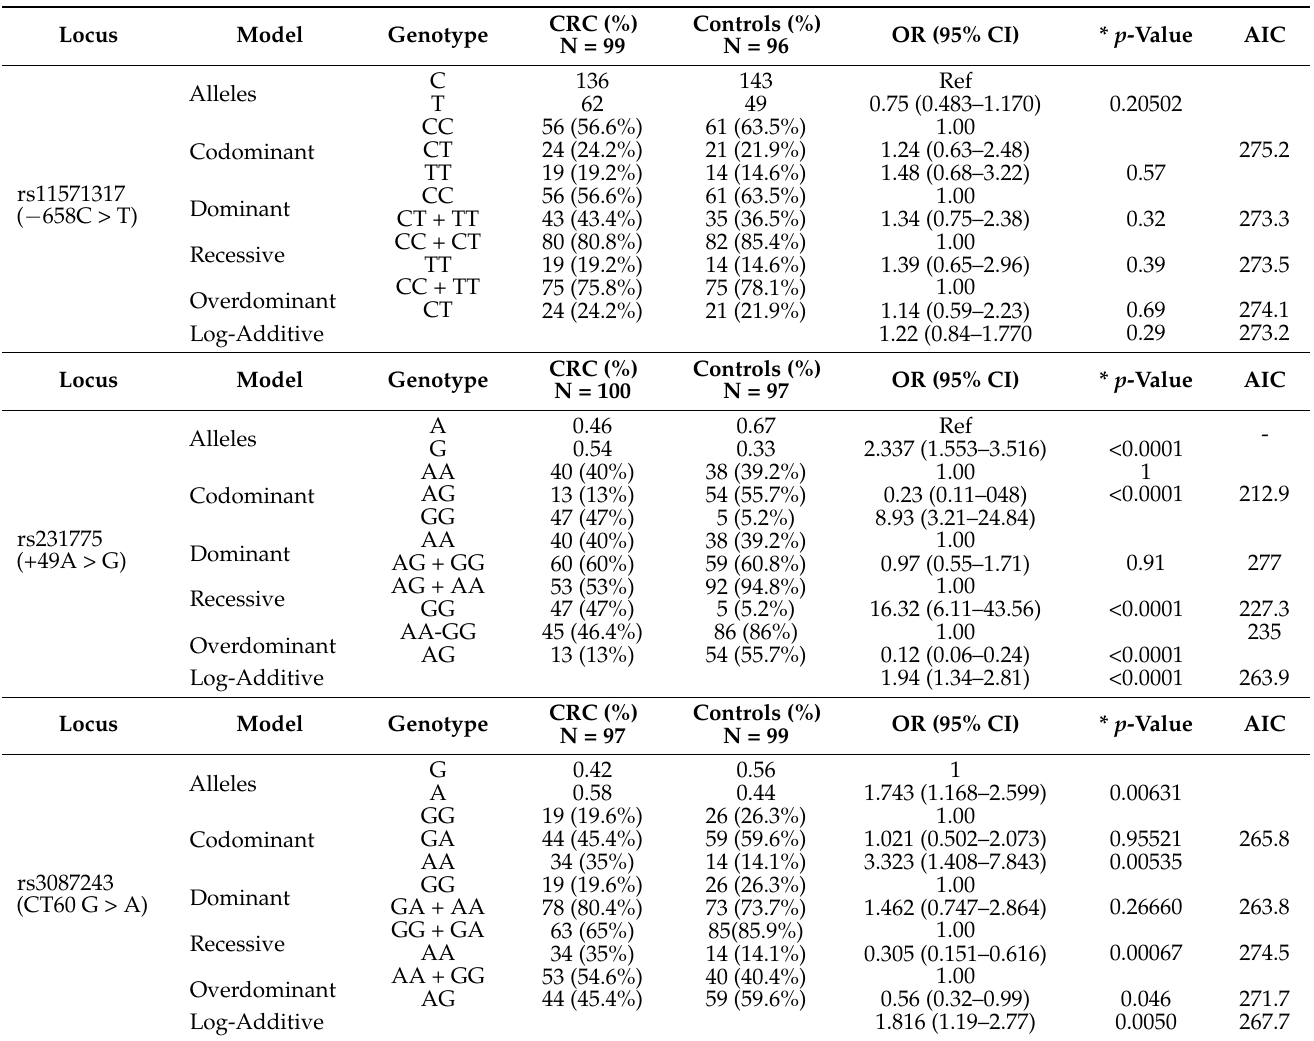
Table 3. Distribution of CTLA-4 SNPs genotypes and allele frequencies in colorectal cancer cases and control population. CRC, colorectal cancer; AIC, Akaike information criteria; OR, odds ratio; 95 % CI, 95 % confidence interval. * p < 0.05 was considered